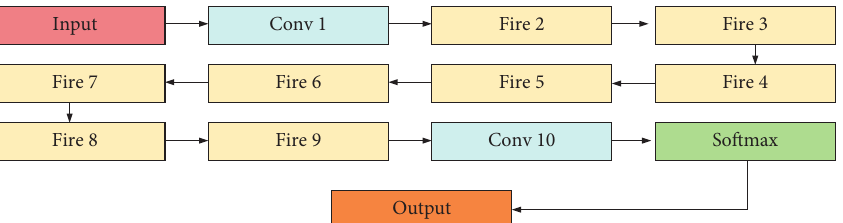
Figure 4: SqueezeNet CNN structure.